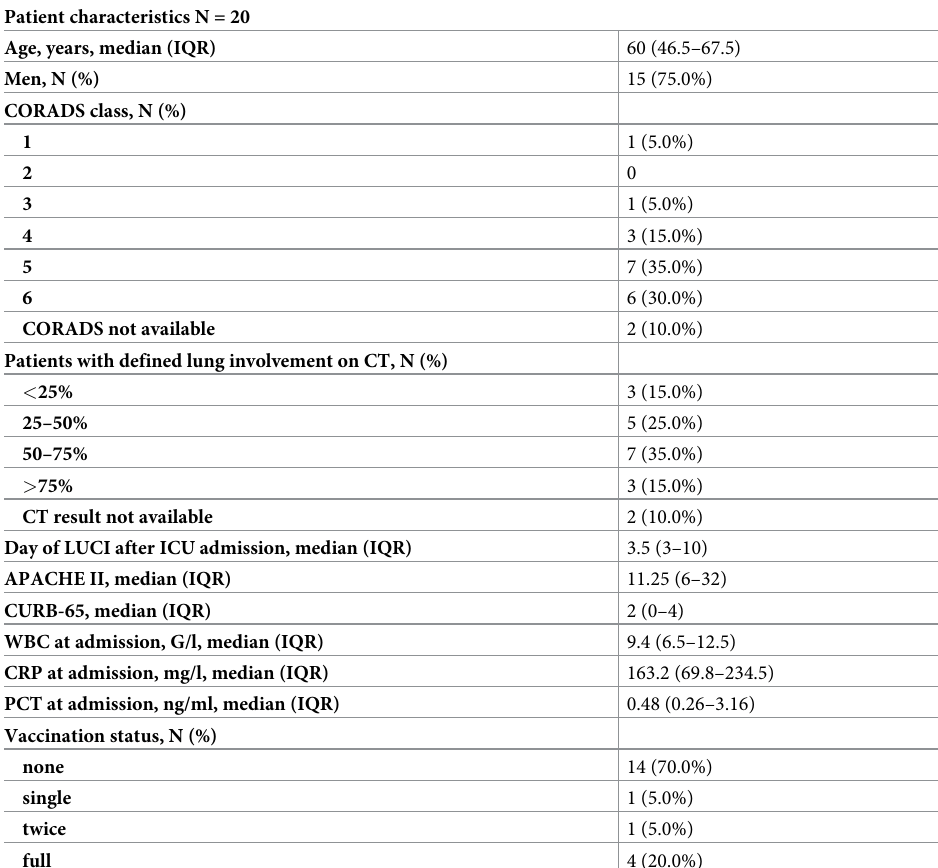
Table 3. Study population.